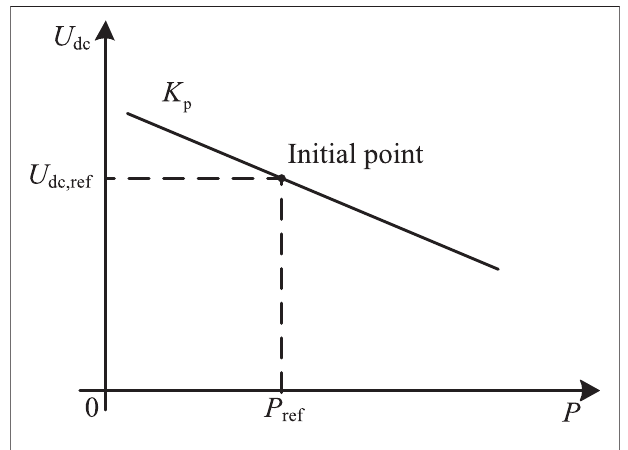
FIGURE 2 | P - U dc droop control schematic